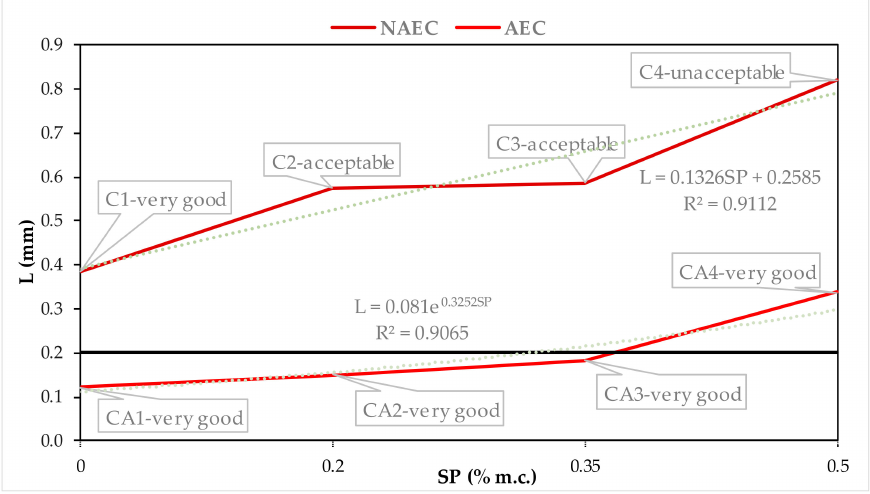
Figure 7. Dependences between L and SP contents in NAEC and